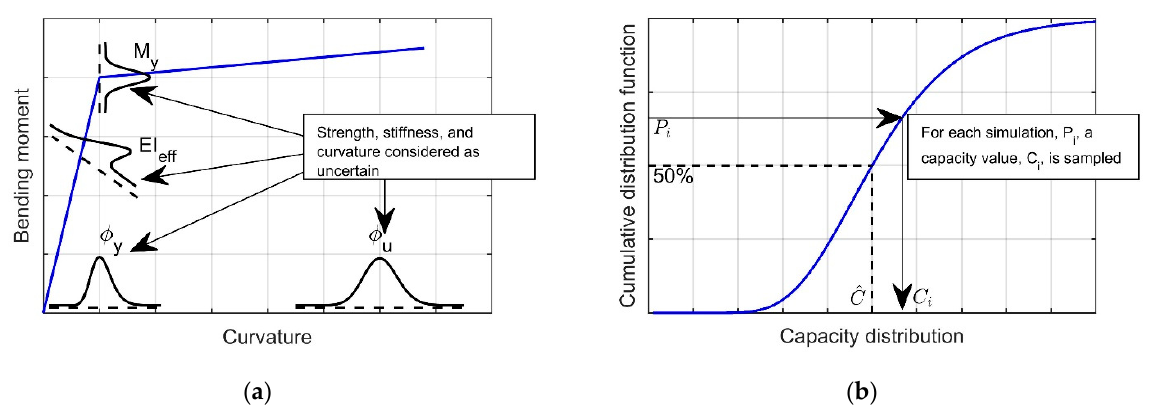
Figure 6 . Probabilistic modeling approach ( a ) overview of variables included in the moment-curvature capacity curve and ( b ) sampling process for each capacity parameter. ( b ) sampling process for each capacity Table 3. Uncertain modeling parameters considered for three case study buildings.